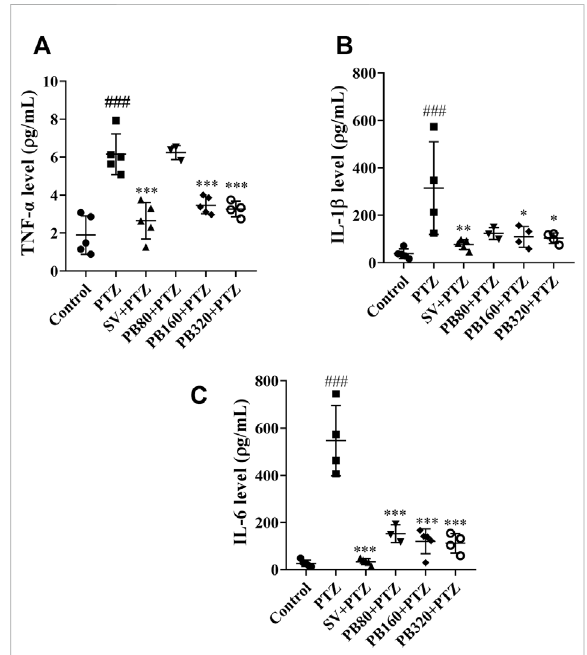
FIGURE 7 The aqueous extract of P. biglobosa decreased the levels of TNF- α (A) , IL-1 β (B) , and IL-6 (C) in the hippocampus. Results are expressed as mean ± SEM, N = 5. Data were analyzed by one-way ANOVA, followed by Tukey (HSD). ### p < 0.001 compared to the control group and *** p < 0.001; ** p < 0.01; * p